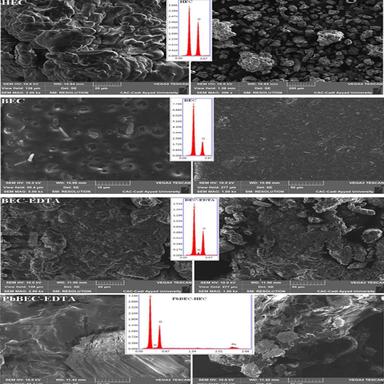
SEM images and EDX spectra of HEC, BEC, BEC-EDTA and BEC-PbEDTA